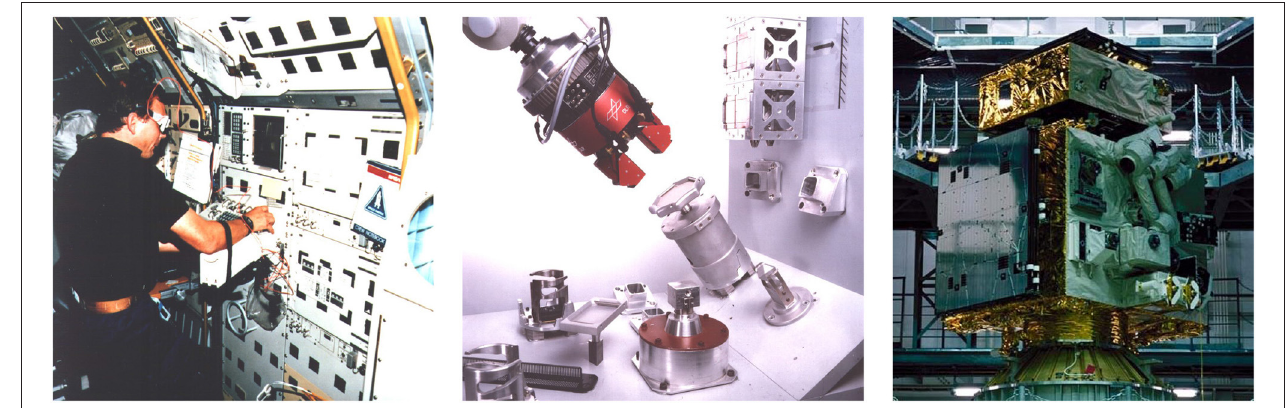
FIGURE 4 | The astronaut Hans Schlegel inside the Space Shuttle Columbia ( left , credit: NASA) controls the robotic gripper of the ROTEX experiment (middle) . The chaser satellite of the ETS-VII mission was equipped with a robot arm ( right , credit: